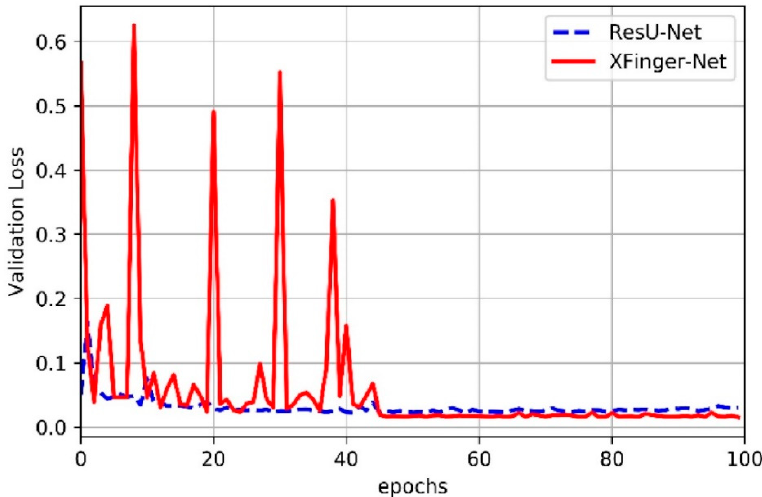
Figure 8. Validation accuracy of XFinger-Net and ResU-net with epoch during training.